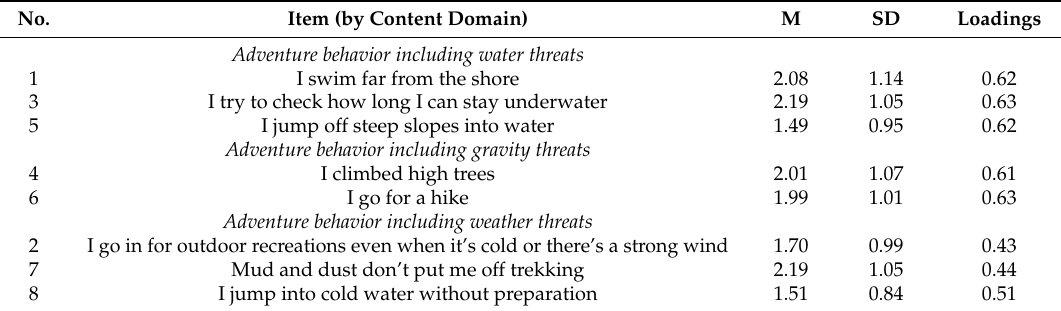
Table 2. Exploratory Factor Analysis of the Adventure Behavior Seeking Scale